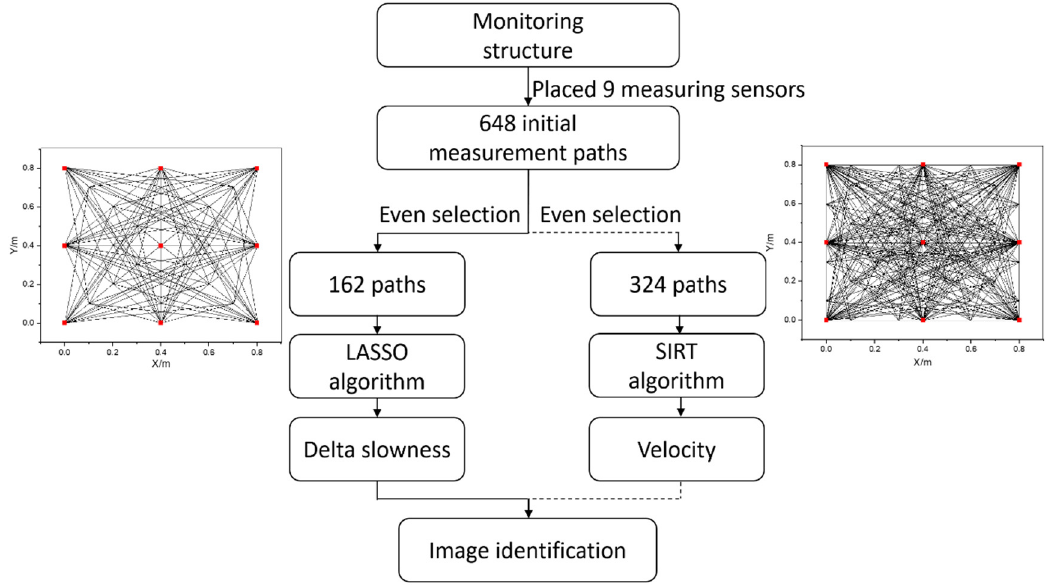
Figure 18. Flowchart of AE tomography in different imaging methods. Table 5. Comparison of the characteristics of different algorithms.